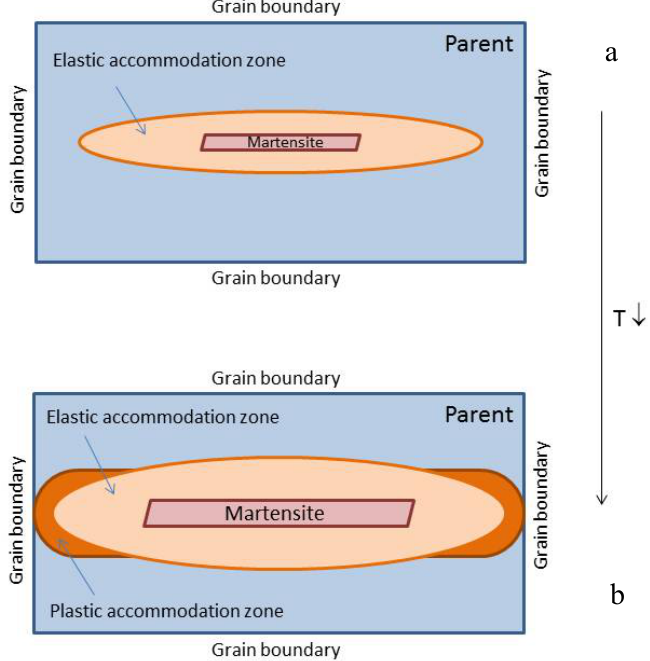
Figure 13. Elastic and plastic accommodation zone around the martensite product in a parent grain of a polycrystalline material. ( a ) During the transitory stages of the martensite propagation, the parent/martensite incompatibilities can be spread to be elastically accommodated, and martensite can be formed as an acoustic wave; ( b ) when the martensite size becomes comparable to the grain size, the incompatibilities must be plastically accommodated.